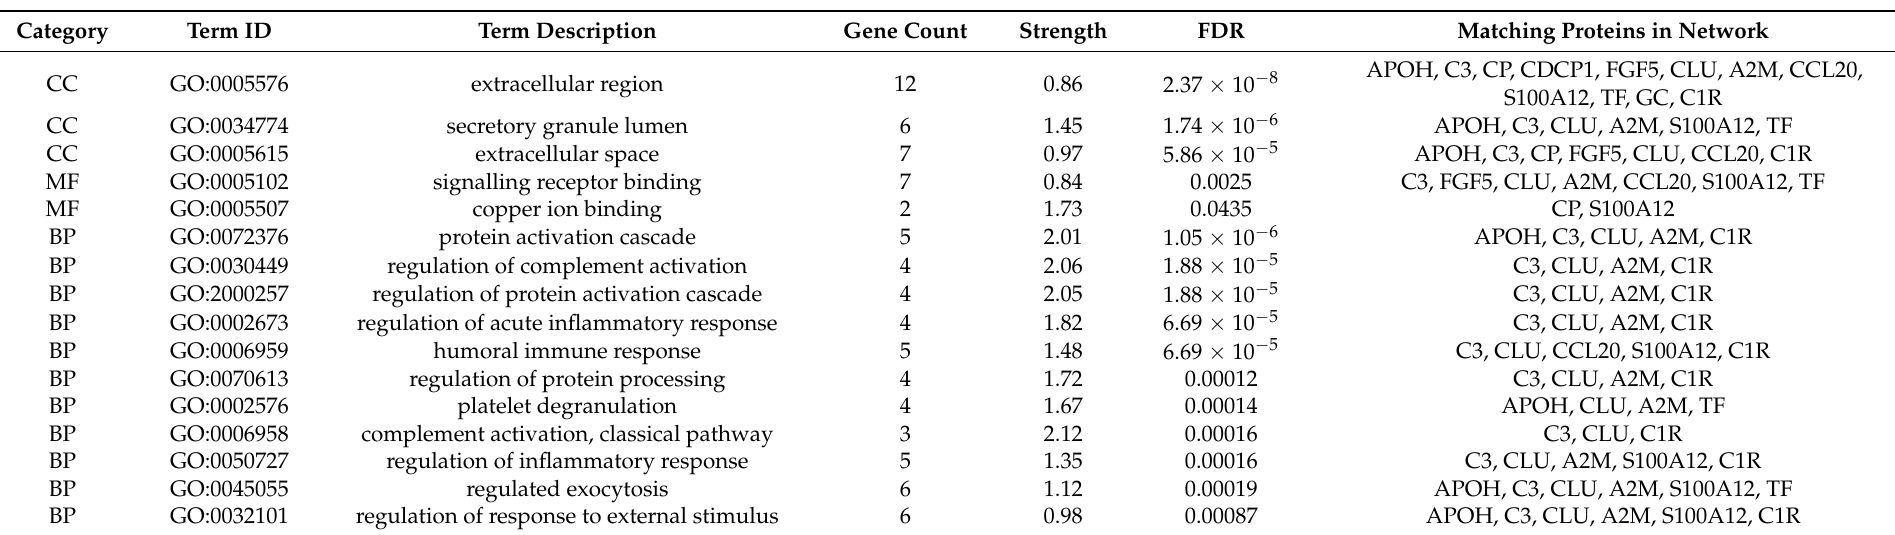
Table 8. The most significant GO terms within cellular component (CC), molecular function (MF), and biological Process (BP) for HPT in CON.